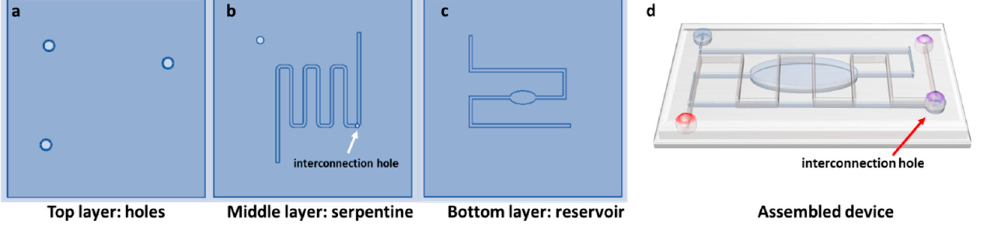
Figure 1. Design of the three layers ( a ) top; ( b ) serpentine; ( c ) bottom and aspects of the assembled device ( d ).